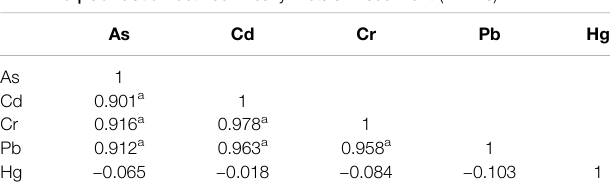
TABLE 6 | Correlation between heavy metals in sediment ( n (cid:2) 20). As Cd Cr Pb Hg As